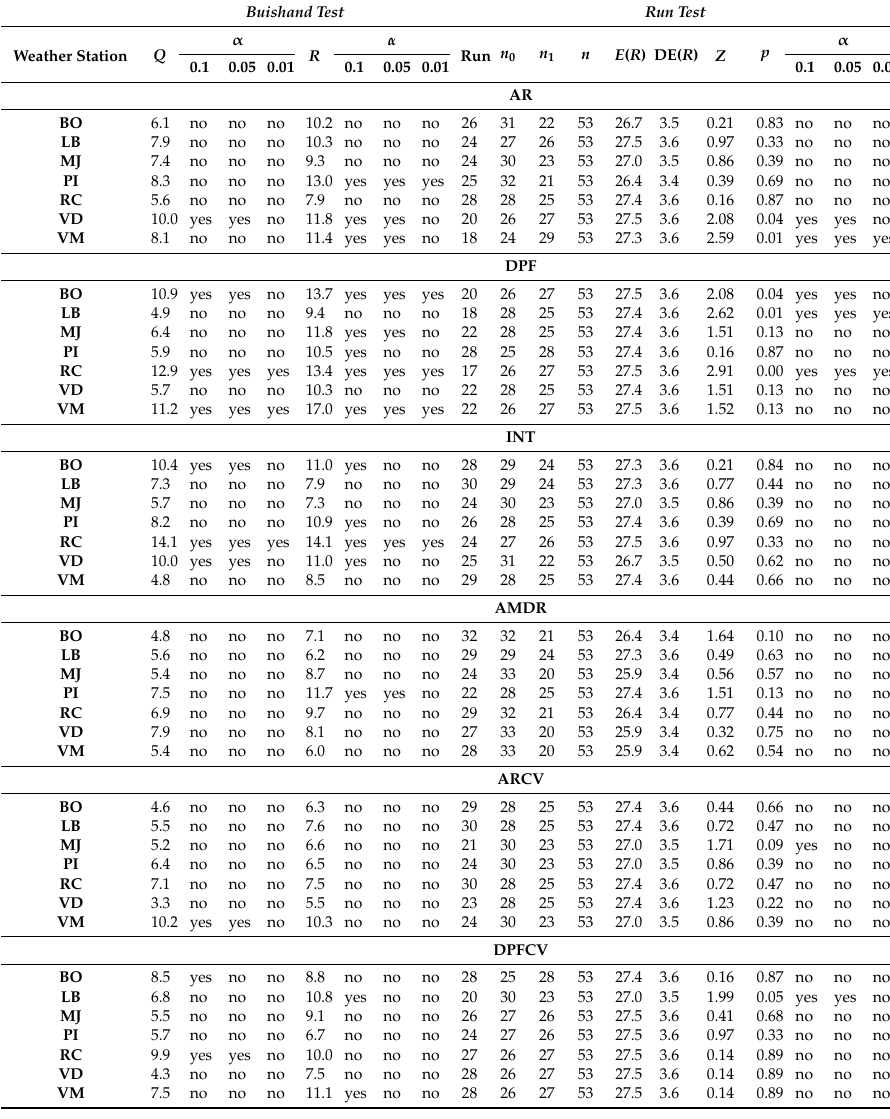
Table 2. Homogeneity assessment of annual rainfall series (total amount (AR), number of rainy days (DPF), mean intensity (INT), maximum daily value (AMDR), variation coefficient of AR (ARCV) and variation coefficient of DPF (DPFCV)) with Buishand procedures (Q and R) and the run test for different weather stations of C ó rdoba, Argentina, and different levels of probability ( α ) in the period between 1960 and 2012. Buishand Test Run